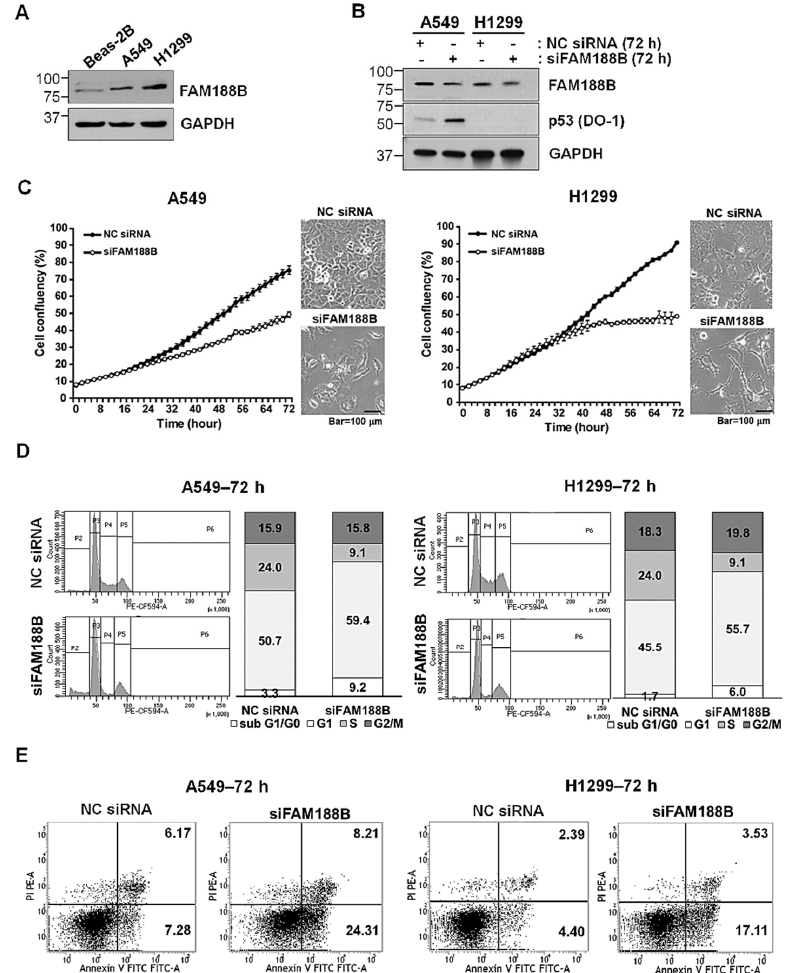
Figure 1. Effects of family with sequence similarity 188 member B ( FAM188B ) knockdown on proliferation and cell cycle in lung cancer cell lines. ( A ) Equal amount of cellular proteins from Beas-B2, a normal lung cell line, and A549 and H1299 lung cancer cell lines was processed for immunoblot analysis using indicated antibodies. GAPDH was used as a loading control. ( B – E ) A549 and H1299 cells were transfected either with non-specific control siRNA (NC siRNA) or siRNA specific for FAM188B (siFAM188B) at indicated times. Cells were then either processed for immunoblot analysis using indicated antibodies ( B ), cell growth analysis using Incucyte™ ( C ), cell-cycle analysis by flow cytometry ( D ), or apoptosis assay by flow cytometry of annexin-V / PI stained cells ( E ). Annexin-V-positive populations were considered as apoptotic populations. Scale bar; 100 µ m. These experiments were performed three times with comparable